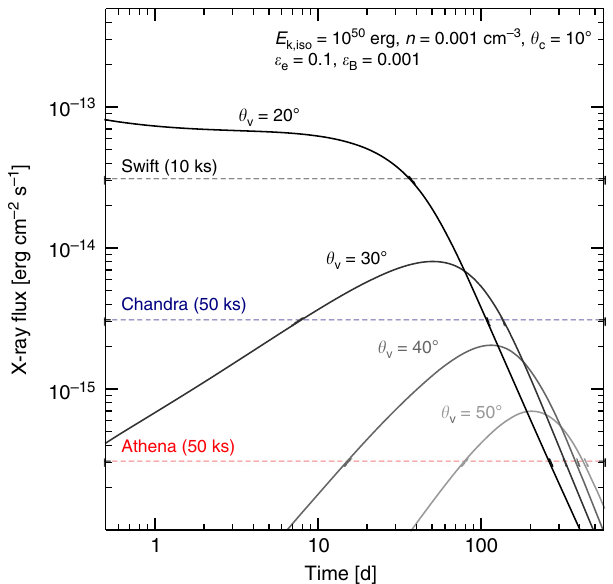
Fig. 7 Predicted X-ray light curves of GW counterparts for different viewing angles. We assumed a set of standard afterglow parameters, reported in the top right corner, and a distance of 100 Mpc. The dashed lines mark the typical sensitivities of present ( Swift, Chandra ) and future ( Athena )